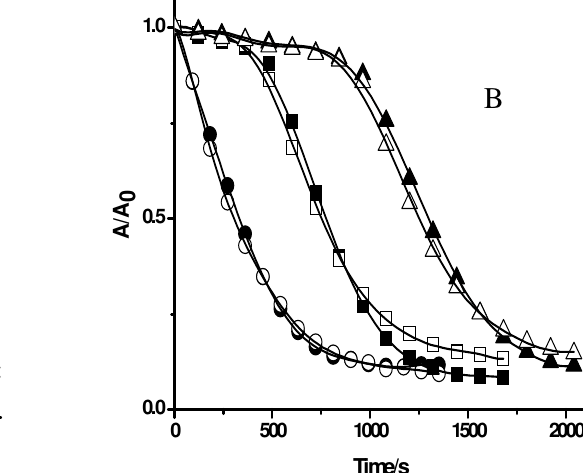
Figure 2. Effect of antioxidants on the consumption of PGR induced by AAPH derived peroxyl radicals in the absence (closed symbols) and presence of Triton X-100 micelles (open symbols). PGR (5 µM) was incubated with AAPH (10 mM) in the absence (circles) and presence of. A : Trolox: 50 (squares), and 100 µM (triangles); B : Ascorbic acid: 5 (squares), and 10 µM (triangles).